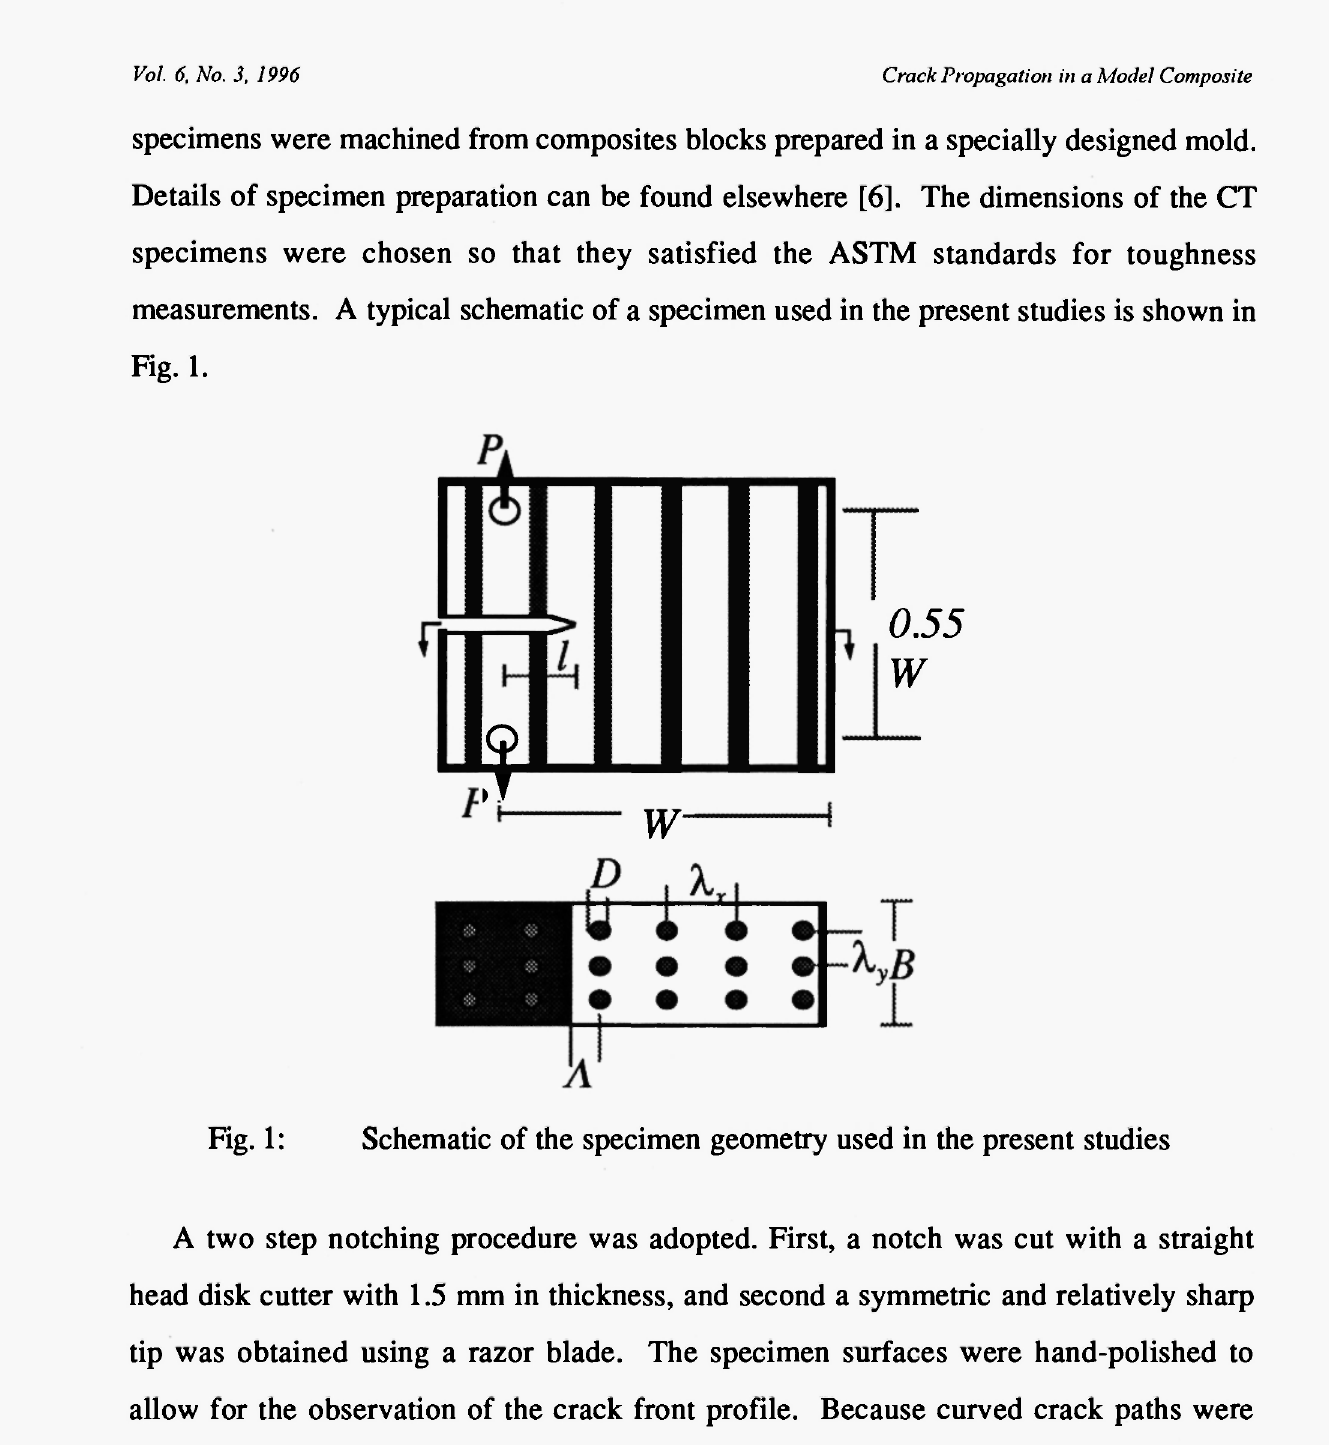
Fig. 1: Schematic of the specimen geometry used in the present